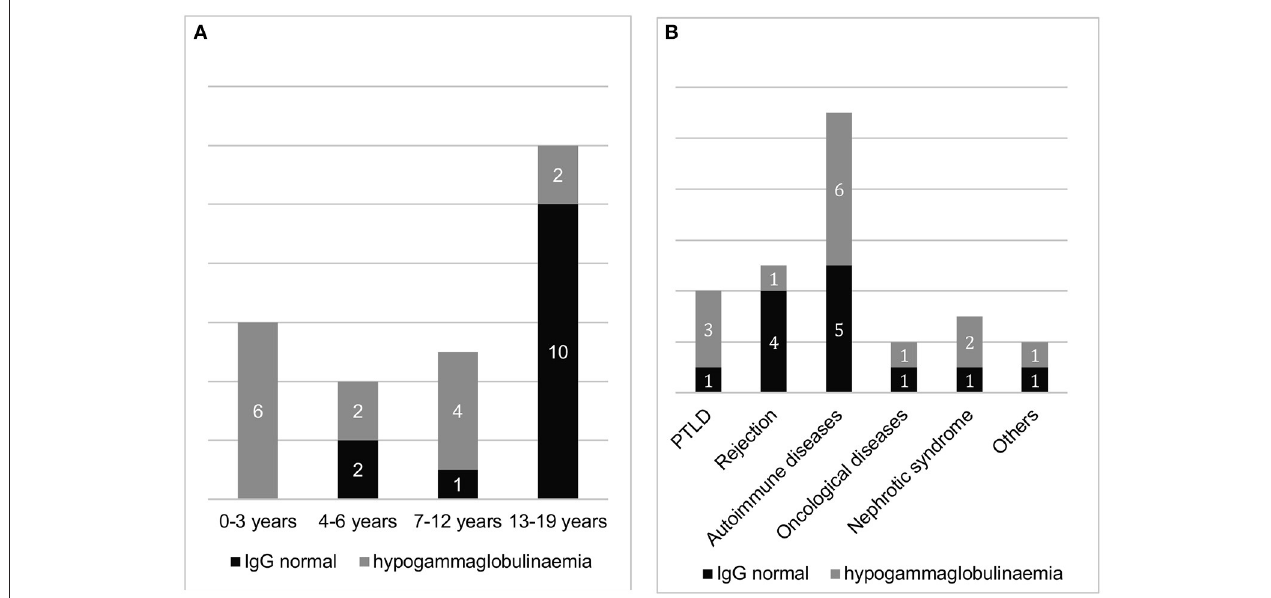
FIGURE 3 | Proportion of patients with and without hypogammaglobulinaemia after RTX treatment (with previously normal IgG levels), (A) : sorted by age group and (B) : sorted by underlying disease ( n =